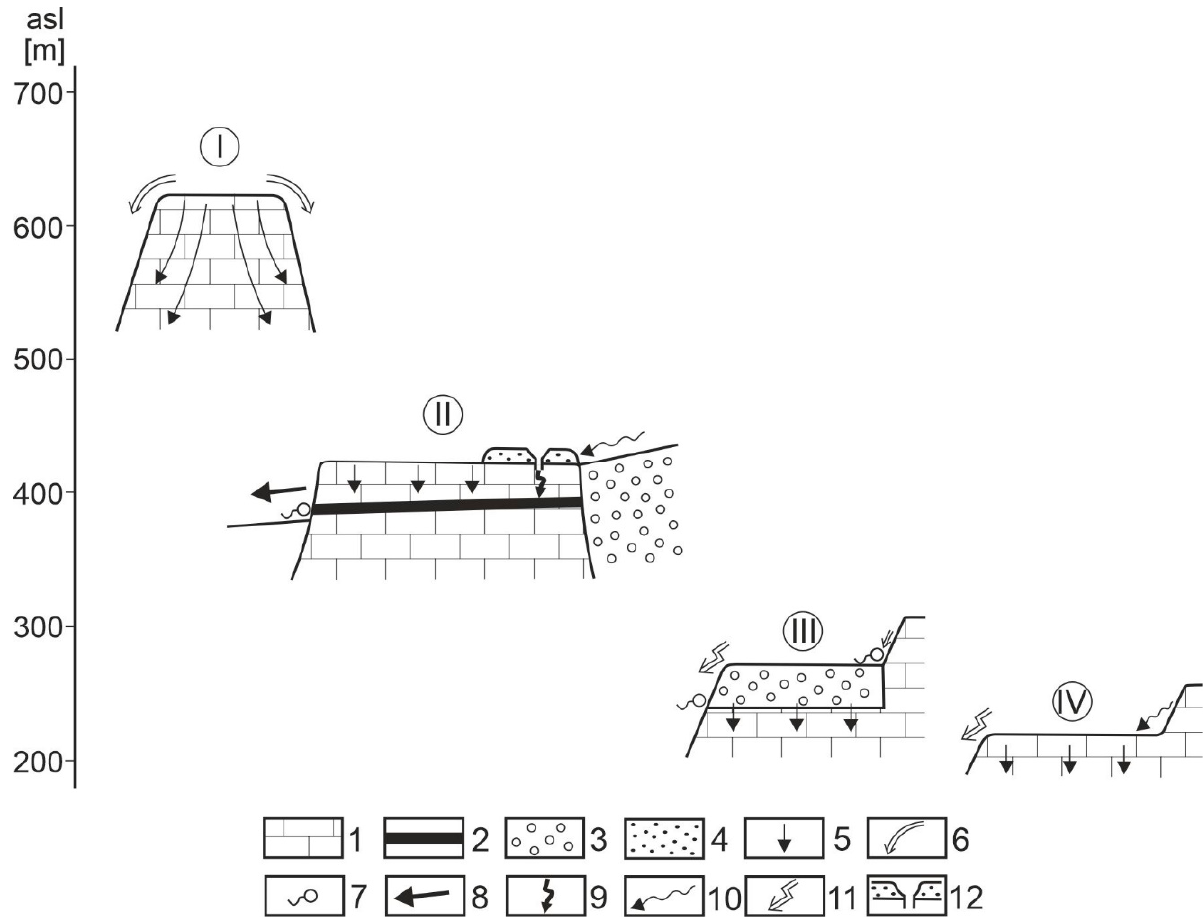
Figure 5. Hydrological cycle of block types. Legend: I. water discharging block (horst in summit position), II. water transmitting block (horst elevated to summit position), III–IV. water catchment and water discharge block (cryptopeneplain threshold surface), 1. Carbonate rock, 2. Impermeable intercalation, 3. Non-karstic aquifer and impermeable rock, 4. Permeable sediment, 5. Areal seepage, 6. Outflow through dry valleys, 7. Spring, 8. Through-flow in dry valleys or in valleys with